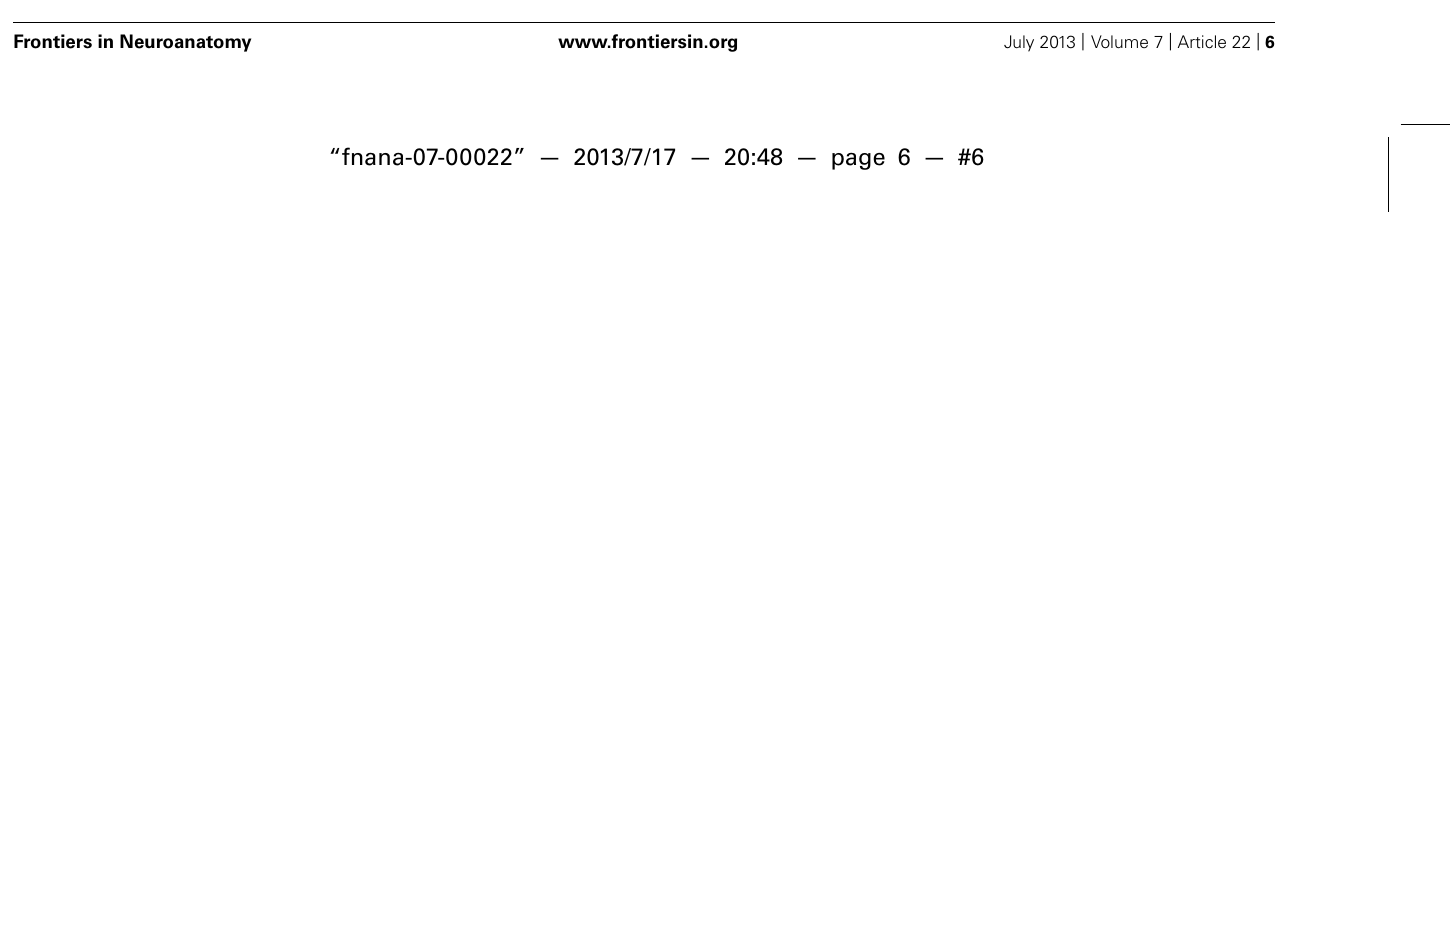
Mash1 (red arrow in A , D–H ). (B) Mash1 induces a first group of transcripts in the phase of expansion of neural progenitors (Castro etal., 2011) and activates a second group of genes at the subsequent phases of cell cycle exit and neuronal differentiation (Bertrand etal., 2002). (C–F) In situ hybridization (ISH) expression pattern of signaling factors in mouse at developmental stage E11.5 (G) Gene expression of signals/factors that helps to define the telencephalic compartmentalization. (H) Subpallial expression of Mash1 at E11.5. All ISH images were taken from the Allen Developing Mouse Brain Atlas, available from: http://developingmouse.brain-map.org. ch, cortical hem; LP, lateral pallium; MP, medial pallium;VP, ventral pallium; SP,